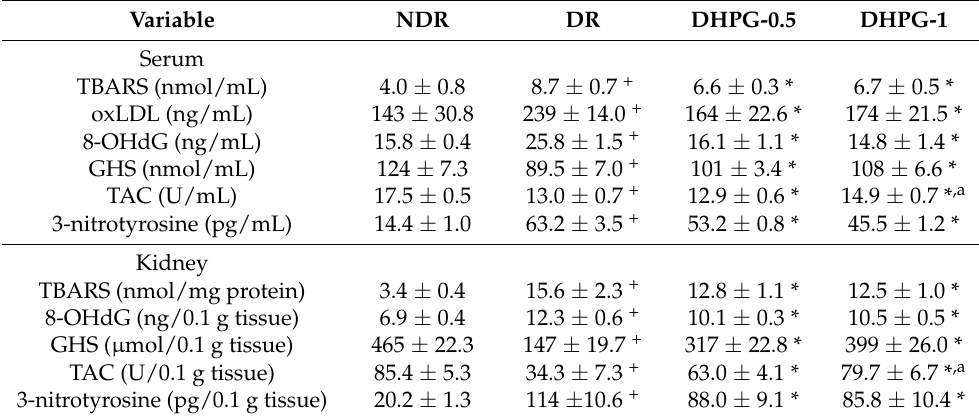
Table 3. Serum and kidney variables (mean ± standard error of the mean) of the oxidative and nitrosative stresses of non-diabetic rats (NDR). Diabetic control rats (DR) and DR were treated with 3 (cid:48) ,4 (cid:48) -dihidroxifenilglicol (DHPG) 0.5 or 1 mg/kg/day p.o. (DHPG-0.5. DHPG-1). N = 10 rats per group.